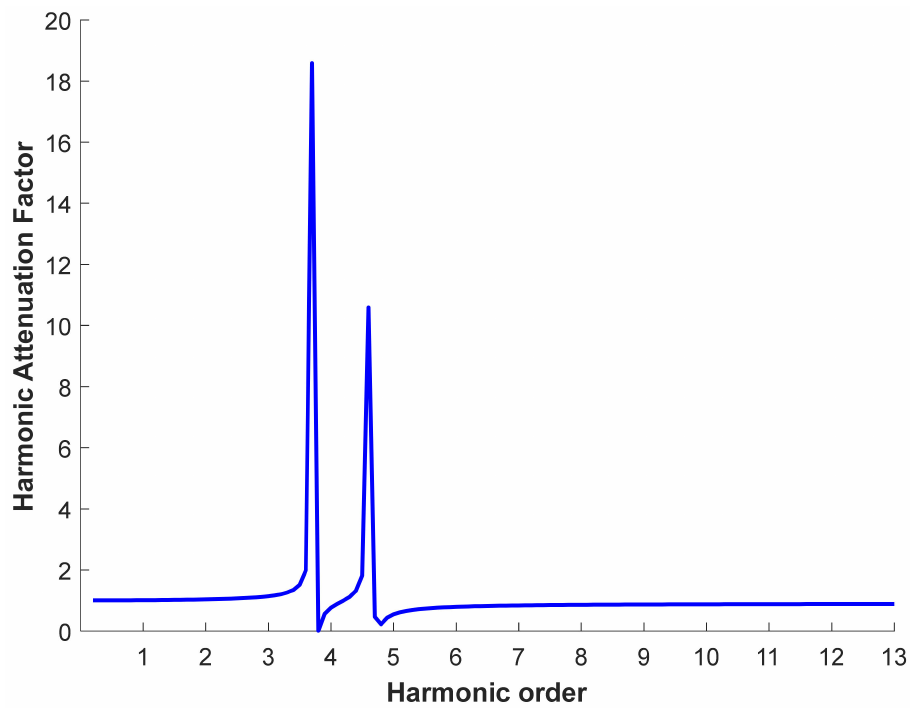
Figure 8. Harmonic attenuation factor with respect to harmonic order of the candidate